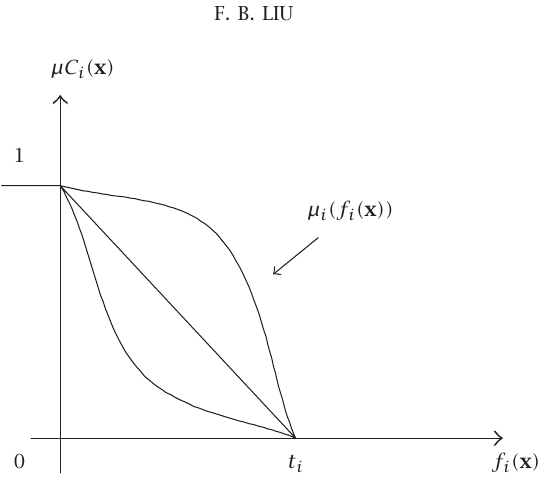
Figure 1.1 . The membership function µ C